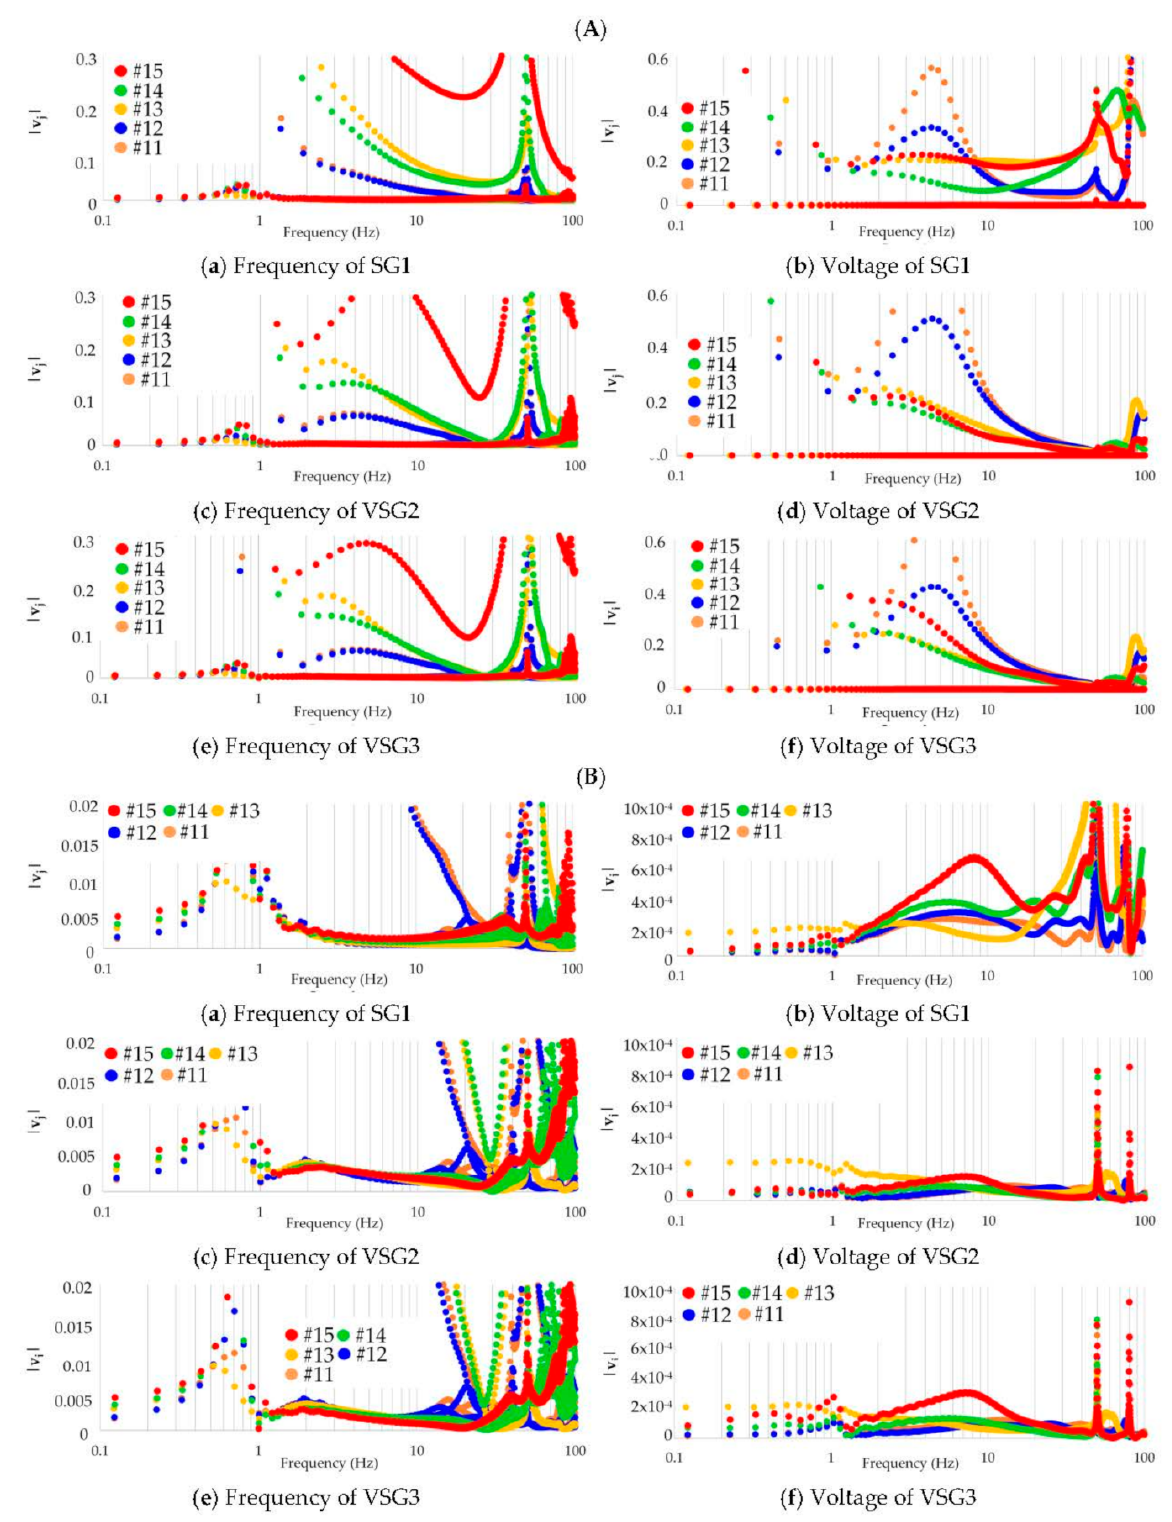
Figure 14. ( A ) Frequency response of the KMs of the system frequency/voltage for tests 11–15 in Table 1. ( B ) Frequency response of the KMs of the system frequency/voltage (enlarged | v i | ) for tests 11–15 in Table